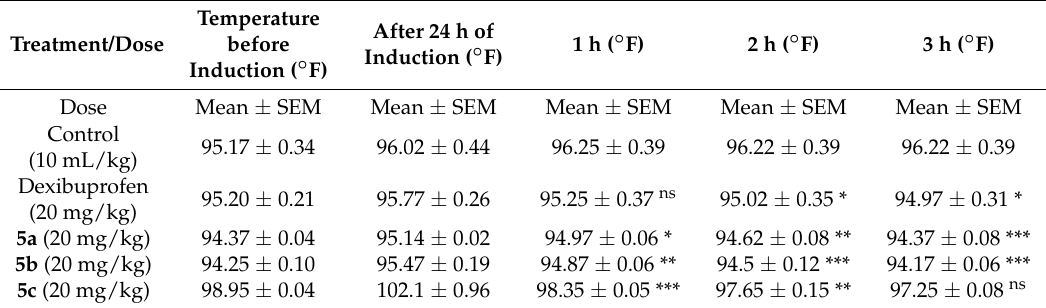
Table 4. Effect of prodrugs ( 5a – c ) against yeast induced pyrexia ( ◦ F) in mice.